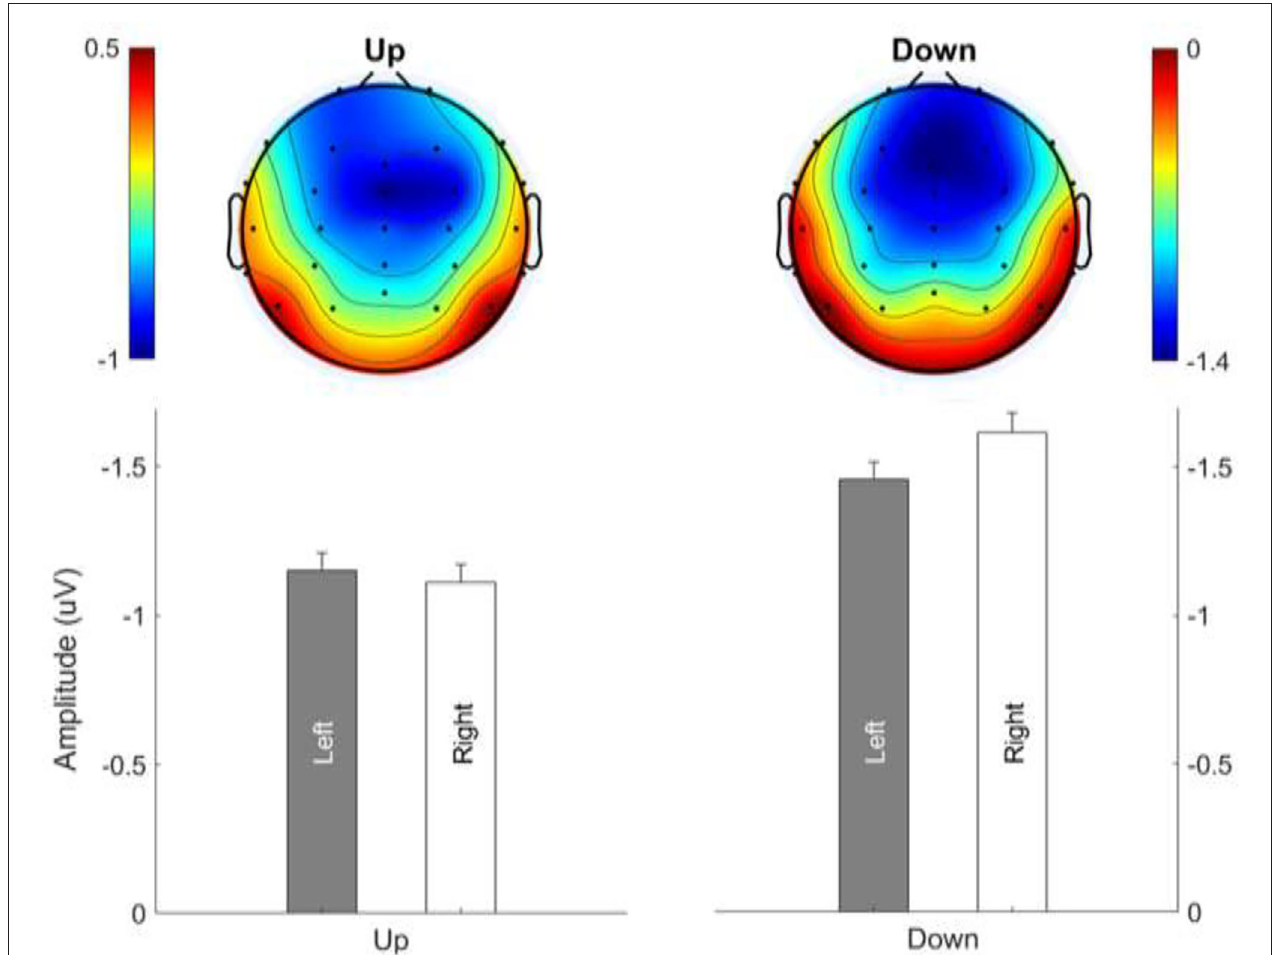
FIGURE 8 | Hemispheric lateralization of MMN topography for upward and downward frequency sweeps. Color bar is scaled to the MMN mean amplitude in each topography. Negativity is indicated by blue and positivity by red color. Downward sweeps showed a right hemispheric dominance.